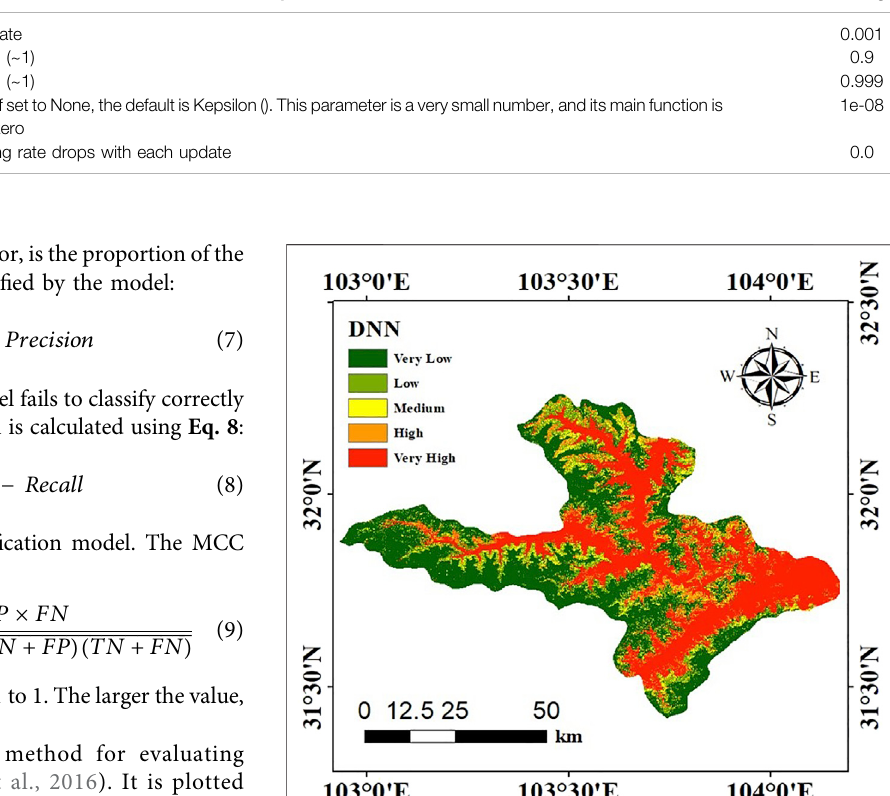
TABLE 4 | DNN model hyper-parameter setting table. Parameter